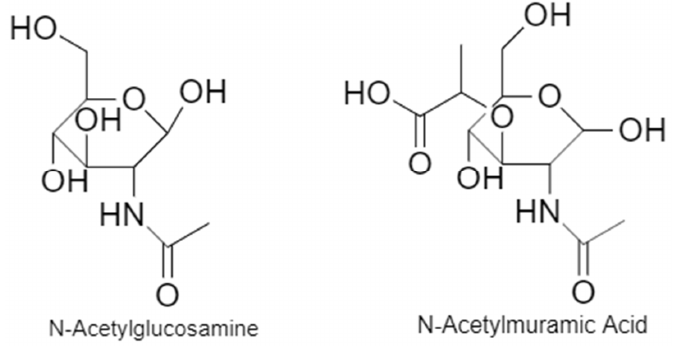
Figure 8. Structure of N-acetylglucosamine and N-acetylmuramic acid.